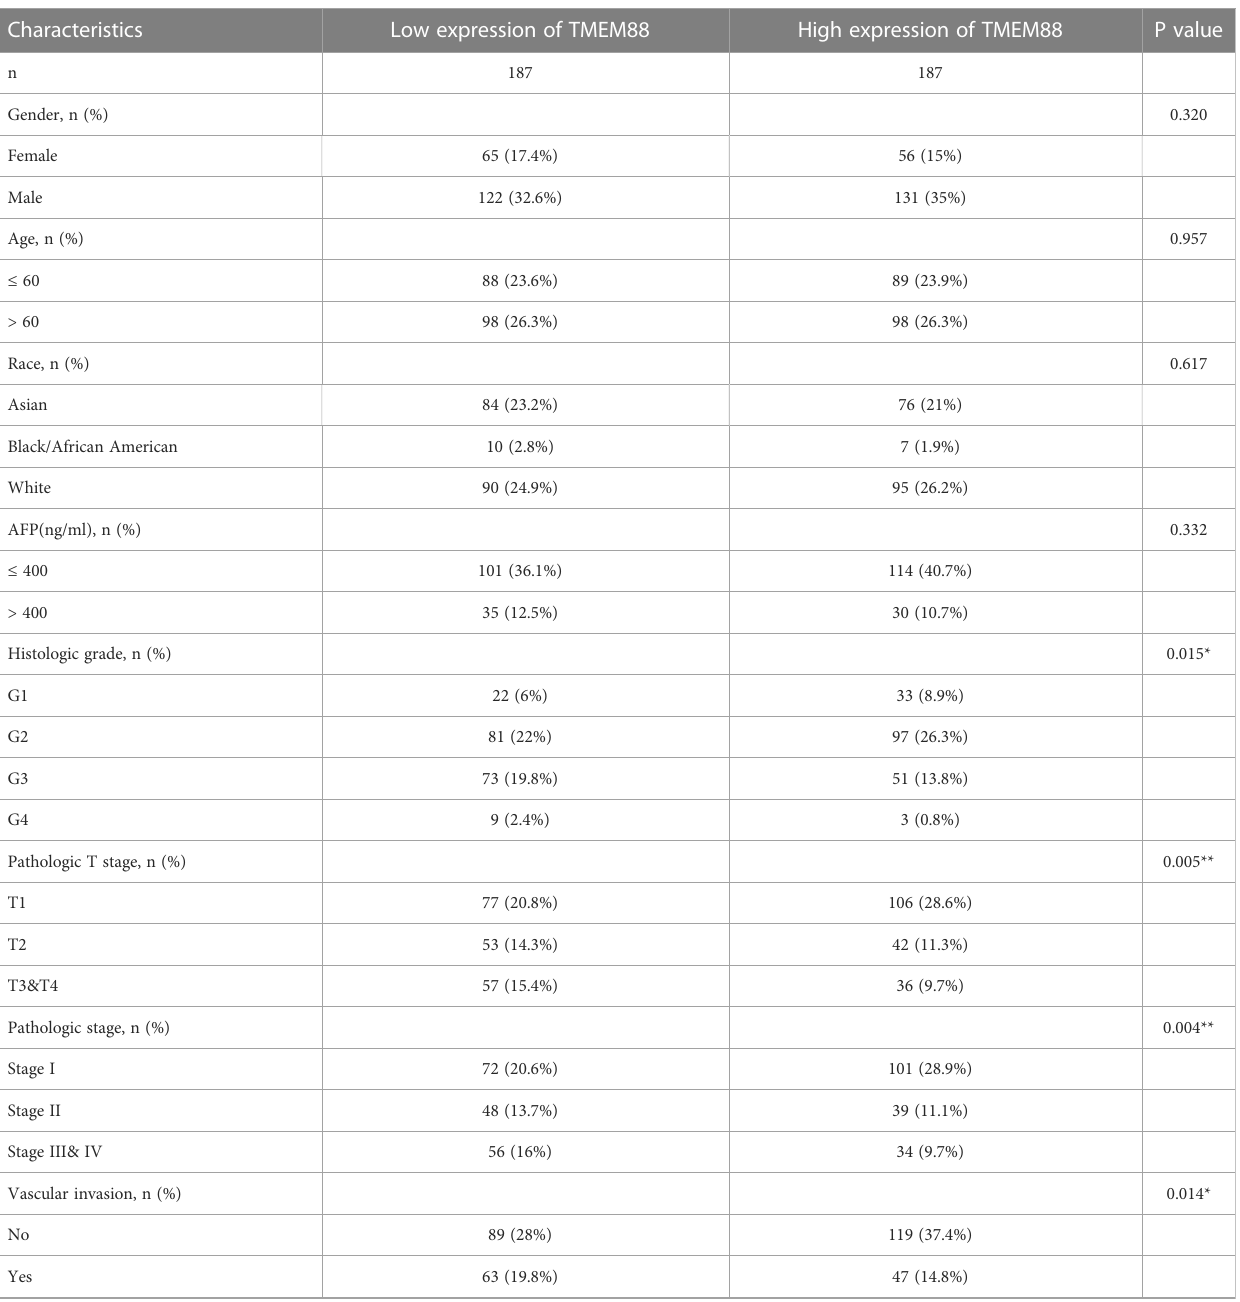
TABLE 1 Correlations between TMEM88 level with HCC